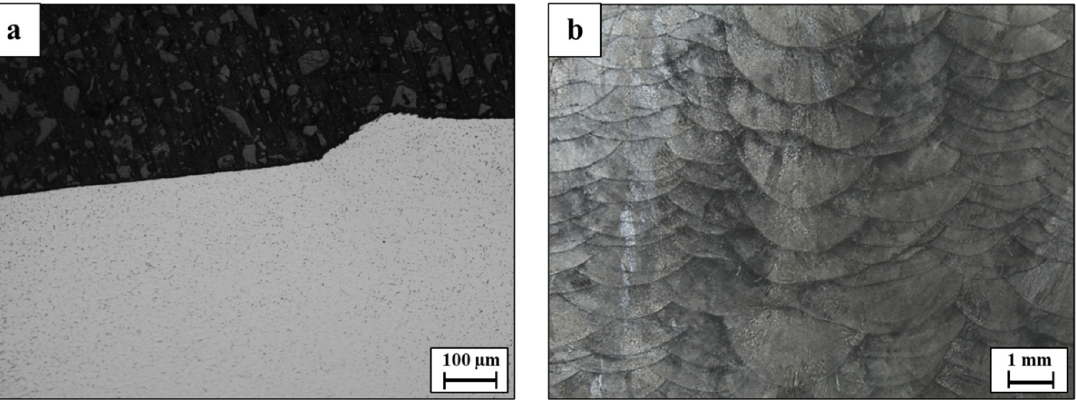
Figure 2. General appearance of WLAM 316L stainless steel. ( a ) Typical surface roughness. ( b ) Macrostructure on XZ plane.